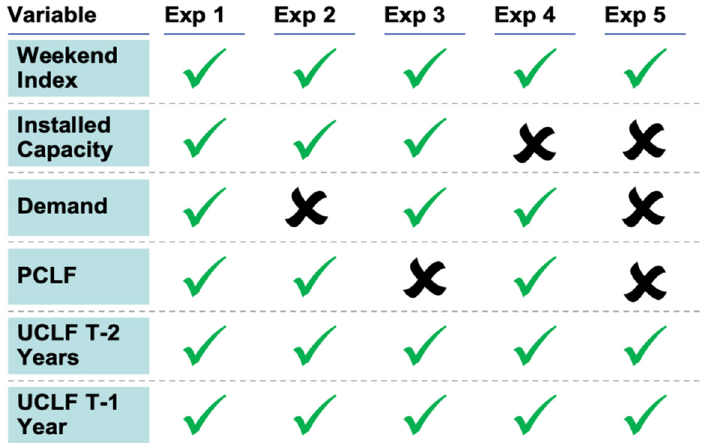
Figure 6. Variables used in the different experiments conducted per technique.